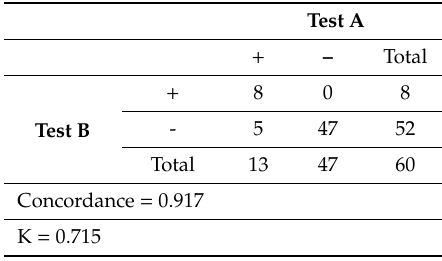
Table 3. Comparison of clinical characteristics between IDH2-mutated and -unmutated